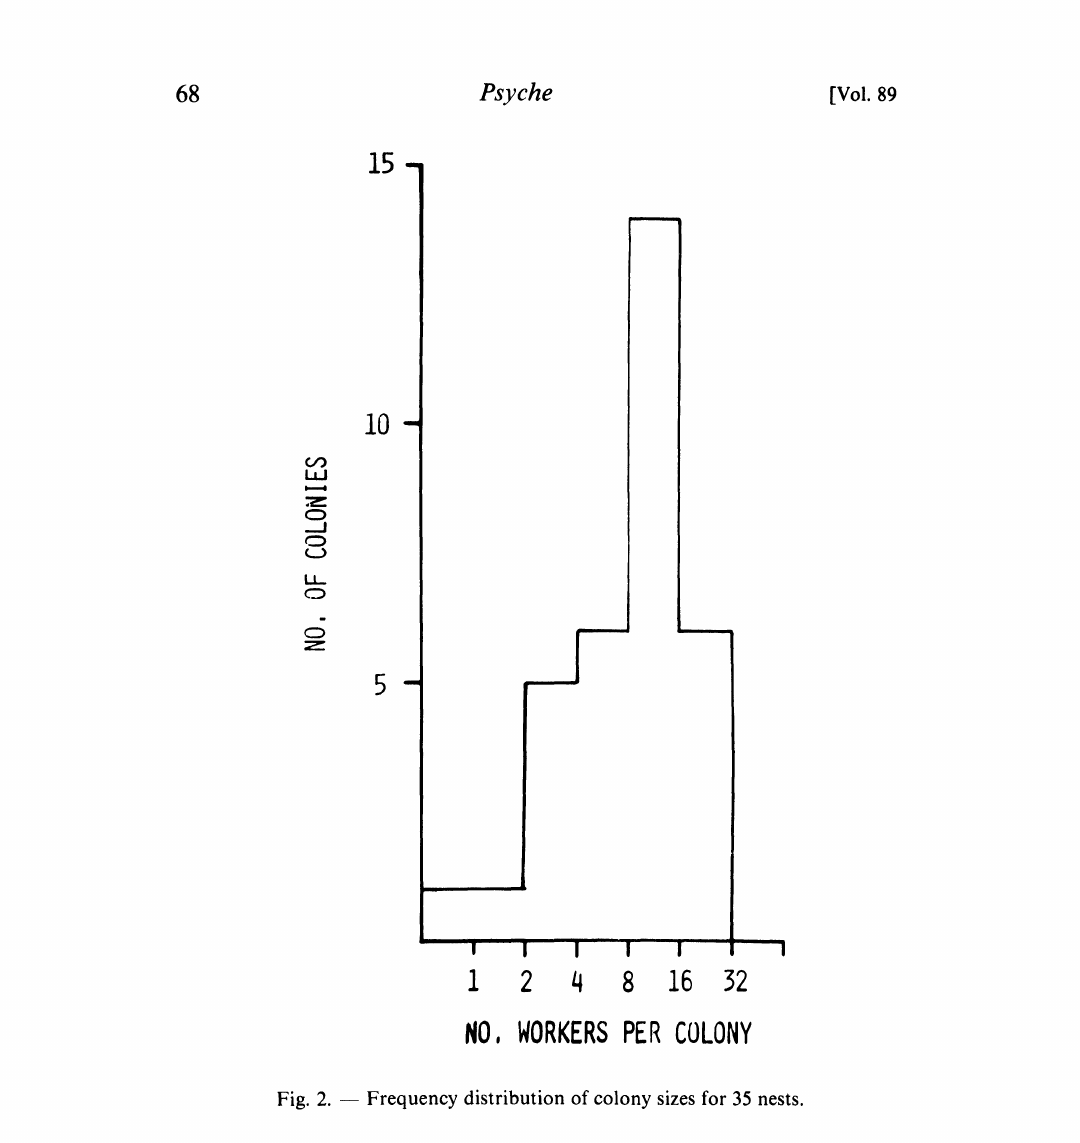
Fig. 2. Frequency distribution of colony sizes for 35